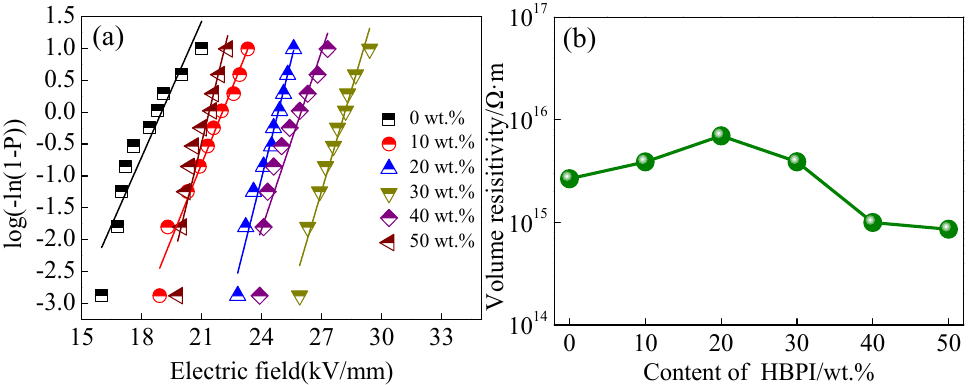
Figure 9. Insulation performance of modified BMI with various levels of HBPI. ( a ) breakdown strength, ( b ) volume resistivity.